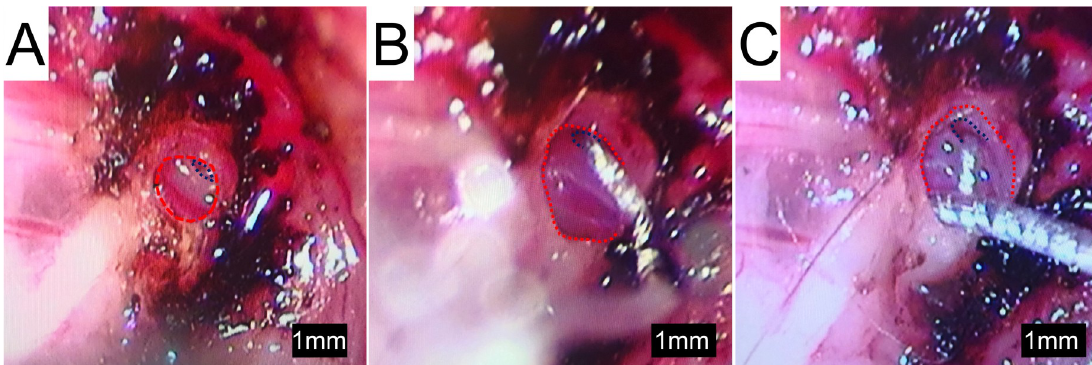
Fig 3. Cochlear implantation surgery. (A) Standard bullostomy (outlined in red) with exposure of the round window (outlined in blue), which is extended inferiorly in (B). After round window CI insertion, part of the implant lead wire is packed into the extended bullostomy cavity for stabilization (C).